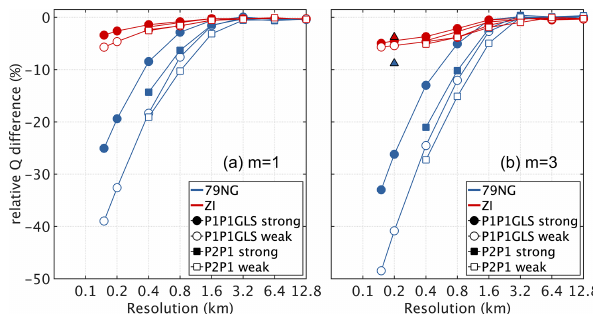
Figure 9. Relative ice mass flux differences between FS and the BP- like stress regimes ( (cid:49)Q FS − BP-like = (Q FS − Q BP-like )/Q FS ) . The location of the flux gates at 79NG and ZI is indicated in Fig. 2. On average the total simulated flux for FS at 79NG is 14.7 and at ZI 14.2Gta − 1 . The triangles in (b) indicate simulations using P1P1GLS weak with a resolution of l = 200m but a re-gridded ge- ometry from a simulation with l = 1600m (see Sect. 6).